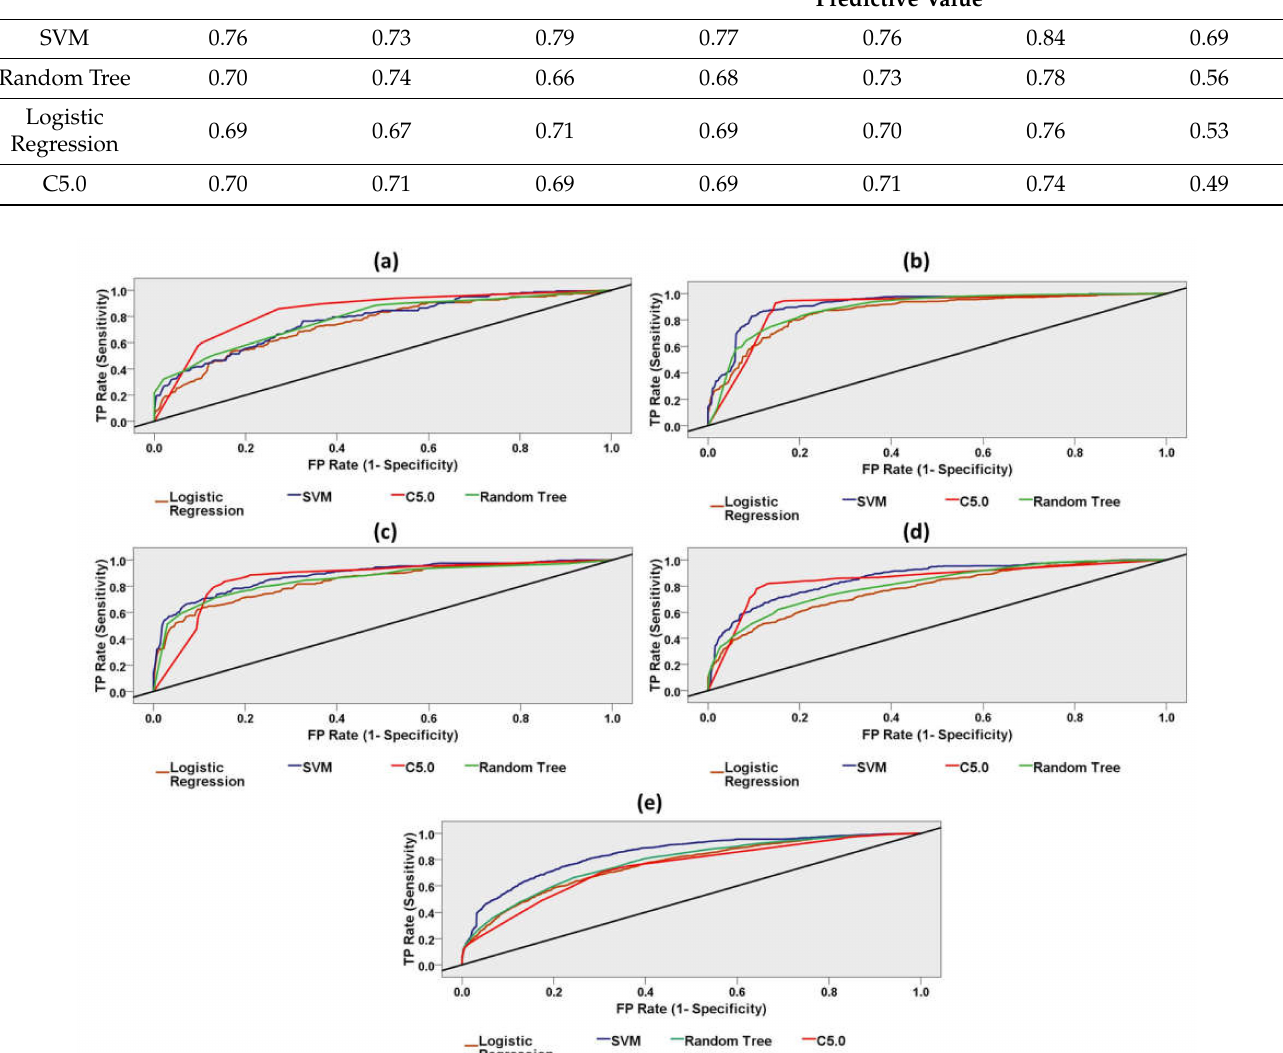
Table 5. Results of the classification performance of different machine-learning models using the task-independent entire dataset. Model